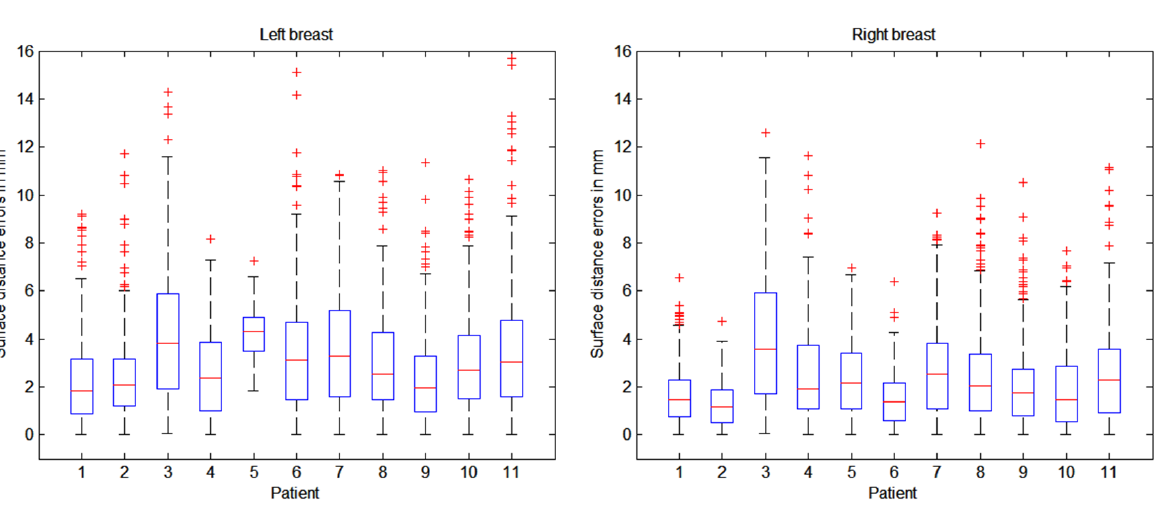
Figure 8. Box plots of left and right breast: 3-dimensional (3D) surface reconstructions compared with laser scans. The patients in Figure 7 correspond to cases 1, 7, and 8, respectively, in these box